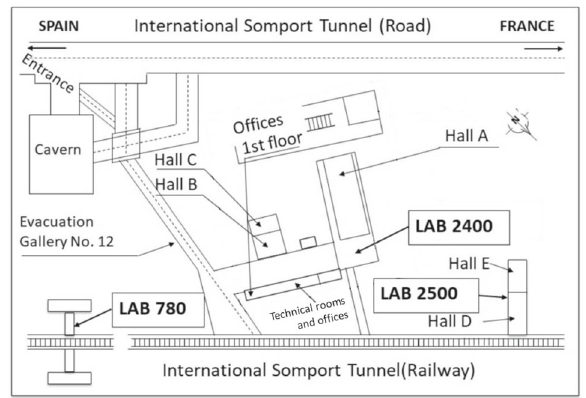
Fig. 1 Scheme (not to scale) of the Canfranc Underground Laboratory facilities